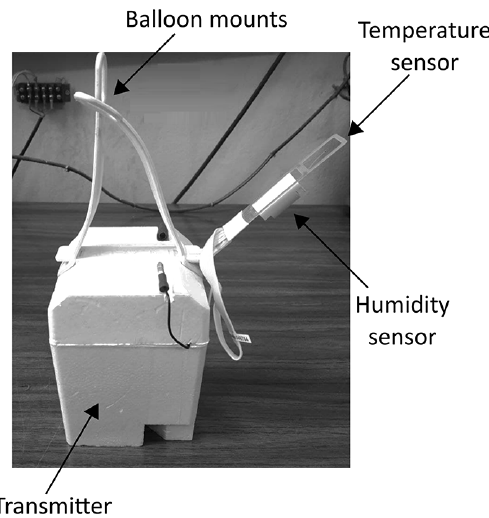
Figure 5. Upper air sonde MRZ-3AK1 (CAO; Dolgoprudny).